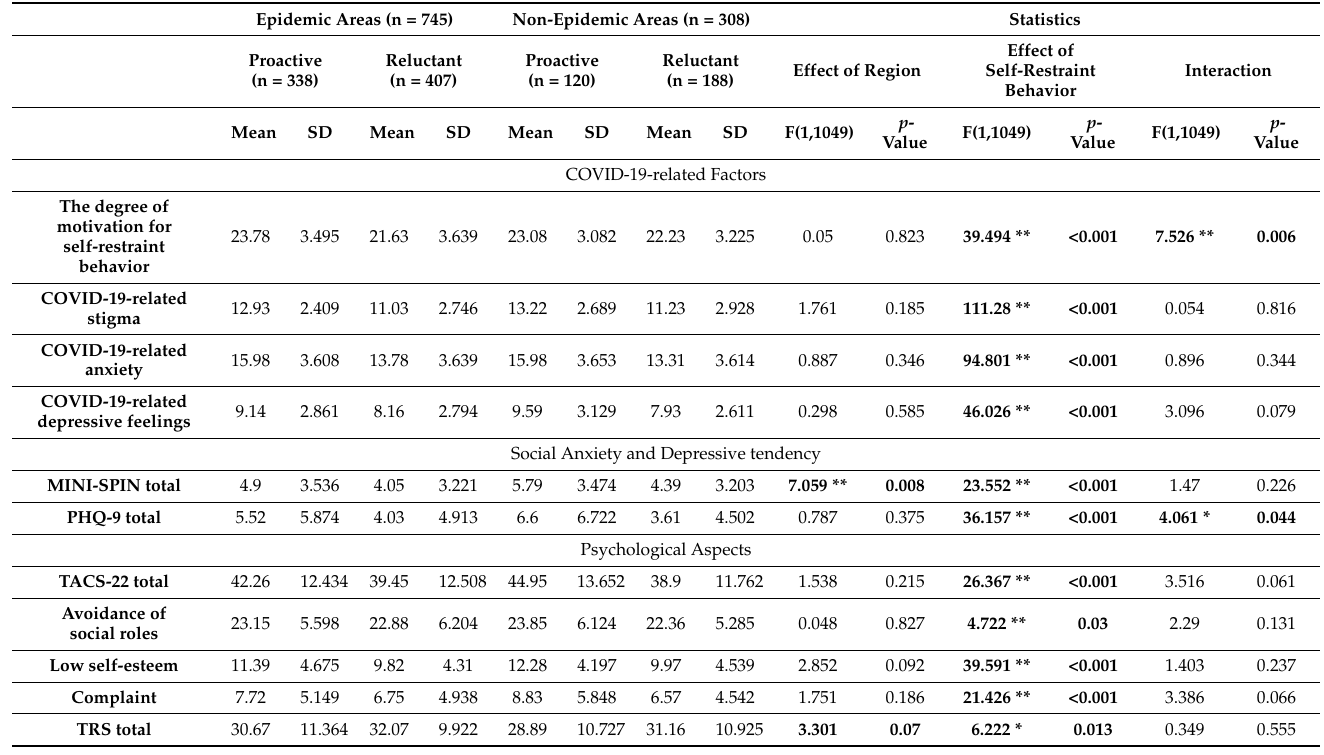
Table 3. Overview of the results of two-way ANOVA for psychological scales. Epidemic Areas (n =